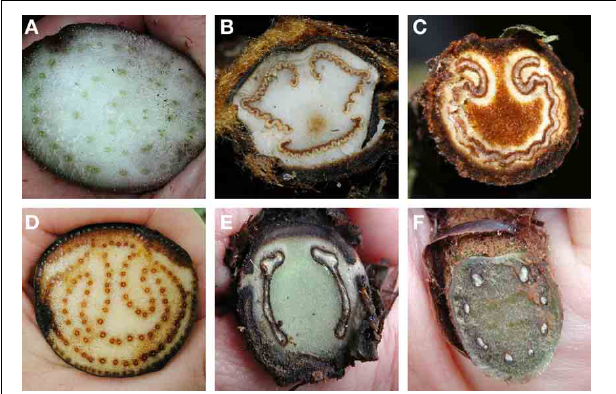
FIGURE 9 | Examples of petiole vasculature in ferns, as seen in cross section. (A) Eupodium laeve (Marattiaceae). (B) Dicksonia sellowiana (Dicksoniaceae). (C) Saccoloma chartaceum (Saccolomataceae). (D) Acrostichum danaeifolium (Pteridaceae). (E) Diplazium hians (Eupolypods II, Athyriaceae). (F) Polystichum concinnum (Eupolypods I, Dryopteridaceae).